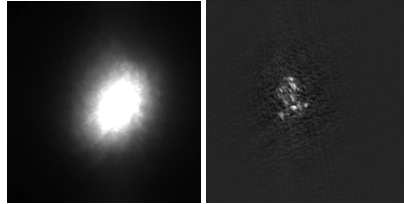
Figure 13. Readout noises (left image). Images restored through 50 frames (right image)